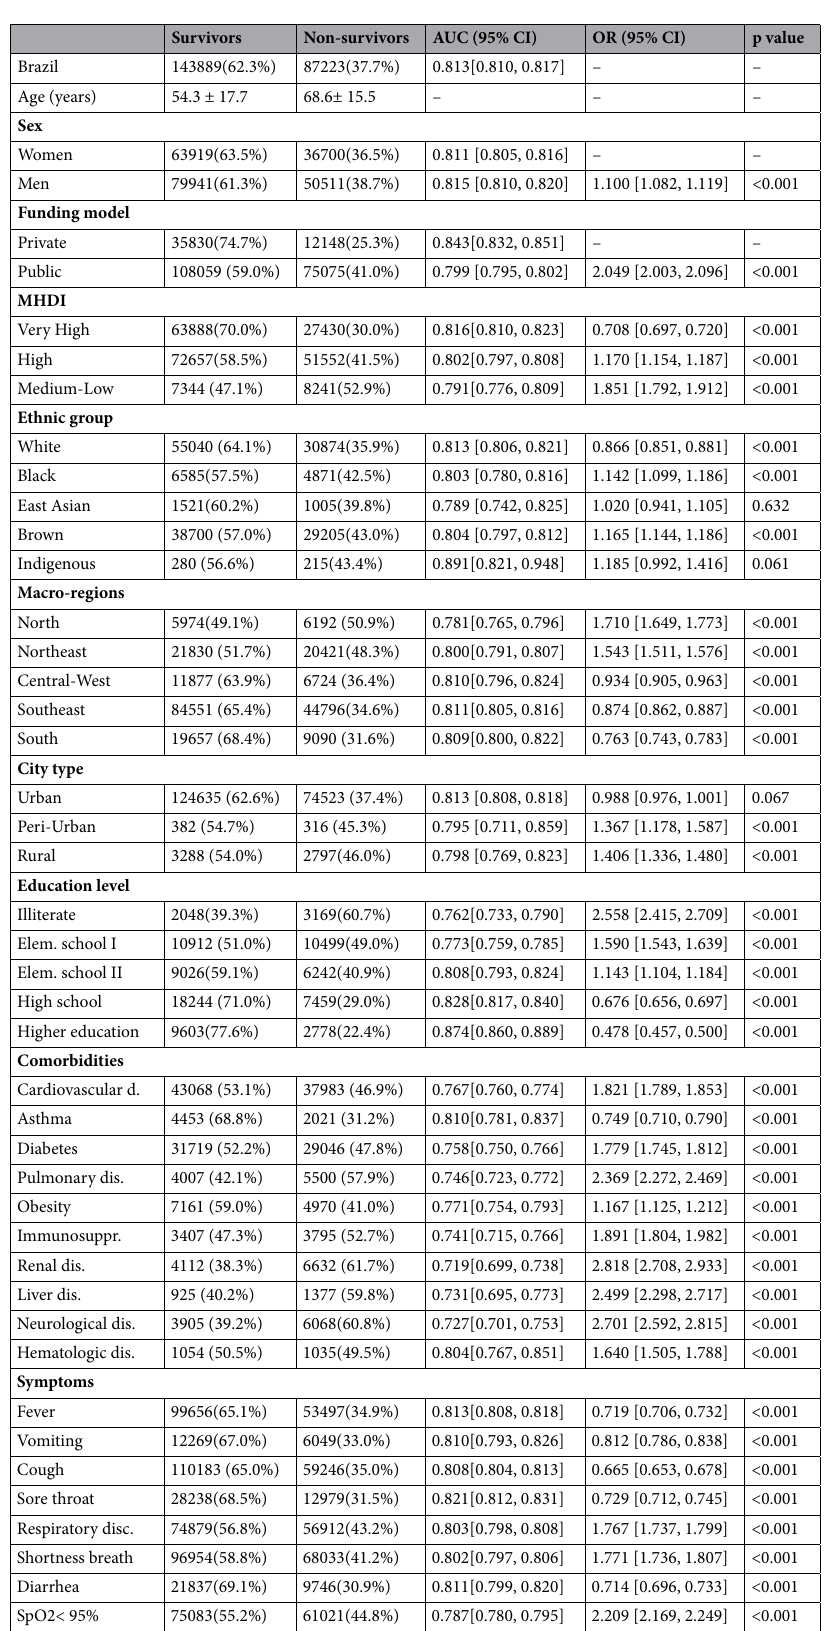
Table 1. Demographic and socio-geographic characteristics and coexisting conditions among survivors and non-survivors of COVID-19. Data are n (%) or mean (SD). The AUC-ROC value is relative to the XGB algorithm for patients belonging to each category. We also show the odds ratios and statistical significance for mortality (univariate